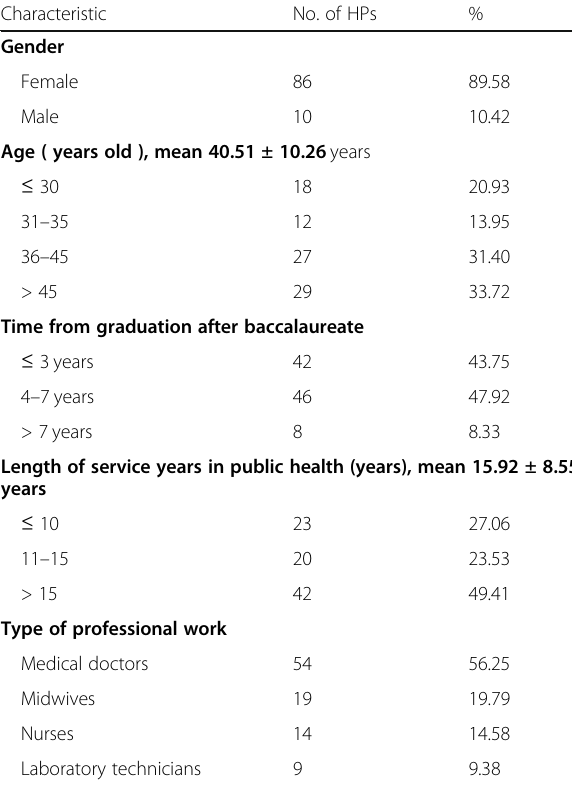
Table 1 Demographic data of the population